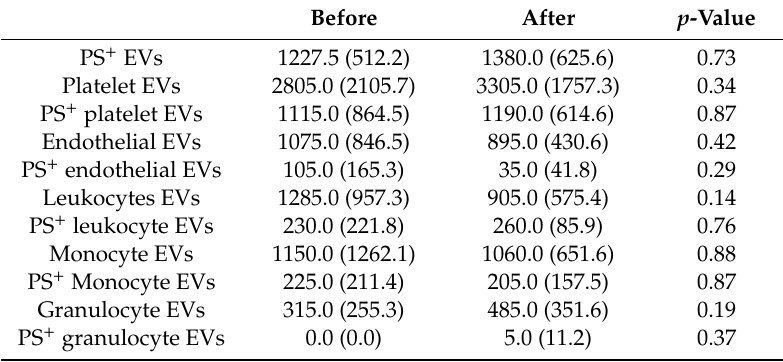
Table 2. EV concentrations before and after RIC in healthy volunteers ( n =